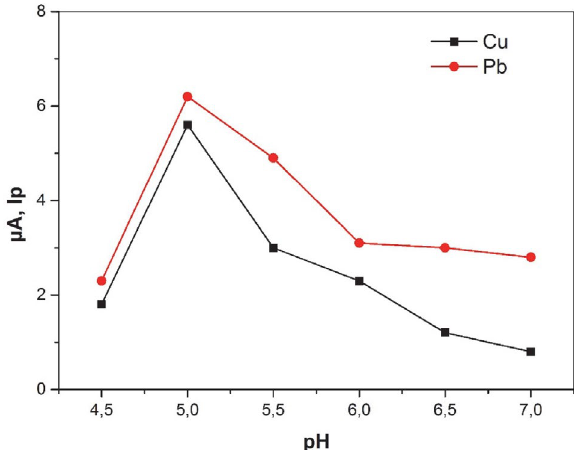
Fig. 5. Effect of pH on the stripping peak current for a solution con- taining 0.20 mol L −1 PBS, 1.0 × 10 −6 mol L −1 Cu(II) and 5.0 × 10 −6 mol L −1 Pb(II); deposition potential: −1.0 V vs. Ag/AgCl, deposi- tion time: 300 s, resting time: 2 s, stirring rate: 300 rpm, scan rate: 0.10 V s −1 .